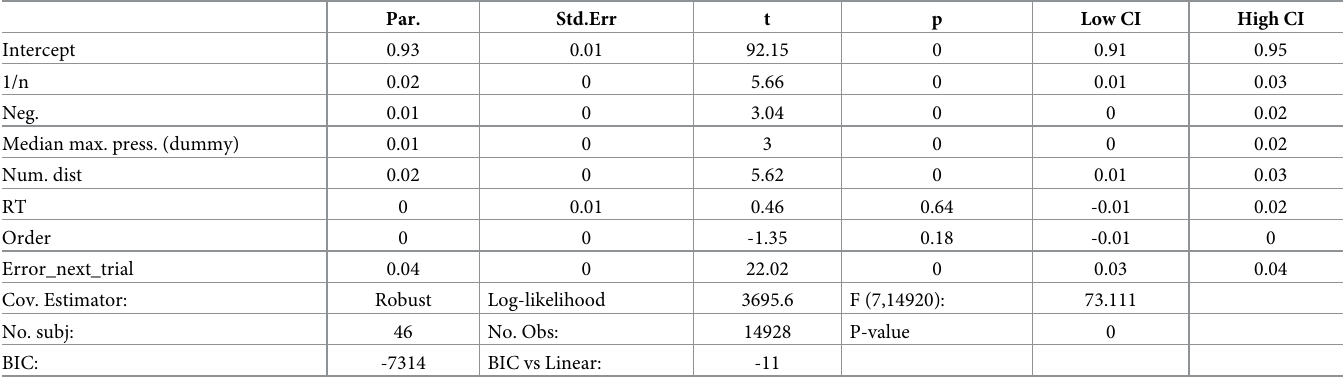
also finds a positive estimate for the median split (Exp. 2: β = 0.01, 95%CI = [0, 0.02], p < 0.01). Correct trials should have higher levels of confidence than incorrect trials for a given discriminability (Fig 1, central panel). Table 2.3 shows that indeed correct trials have higher button pressure (correct estimate), in a regression that controls for numerical distance. Table 2.2. Accuracy. Exp. 2 . Random Effects Estimation. Par.